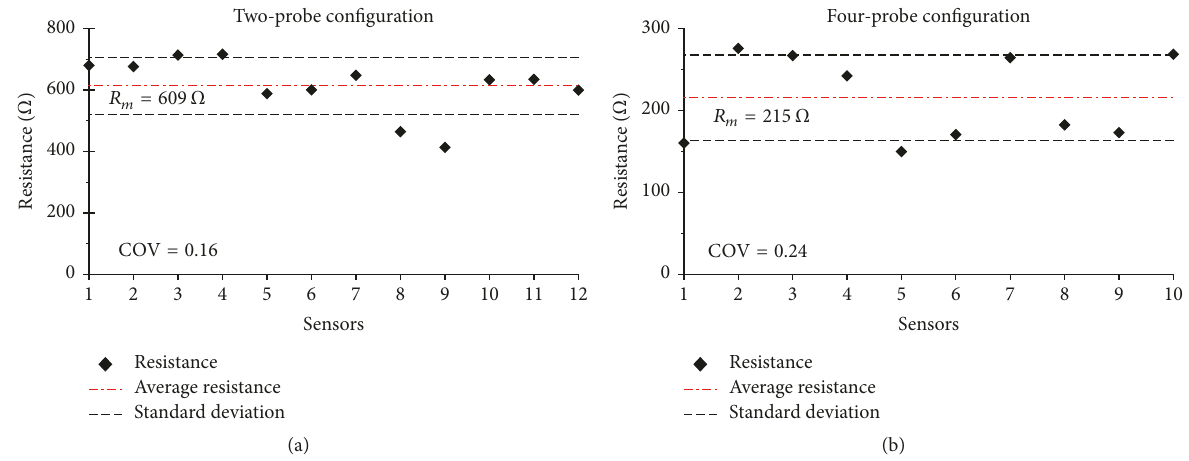
Figure 5: Results of the electrical measurements conducted on all of the CNCTSs (COV denotes the coefficient of variation) using two-probe (a) and four-probe (b)